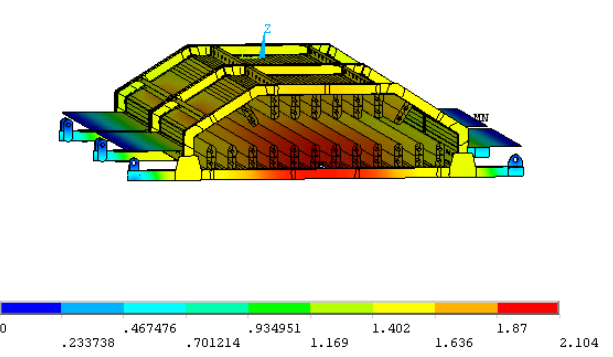
Figure 12: Deflection (mm) in (Z) direction due to loading case 4. Figure 13: Von Mises stress (MPa) due to loading case